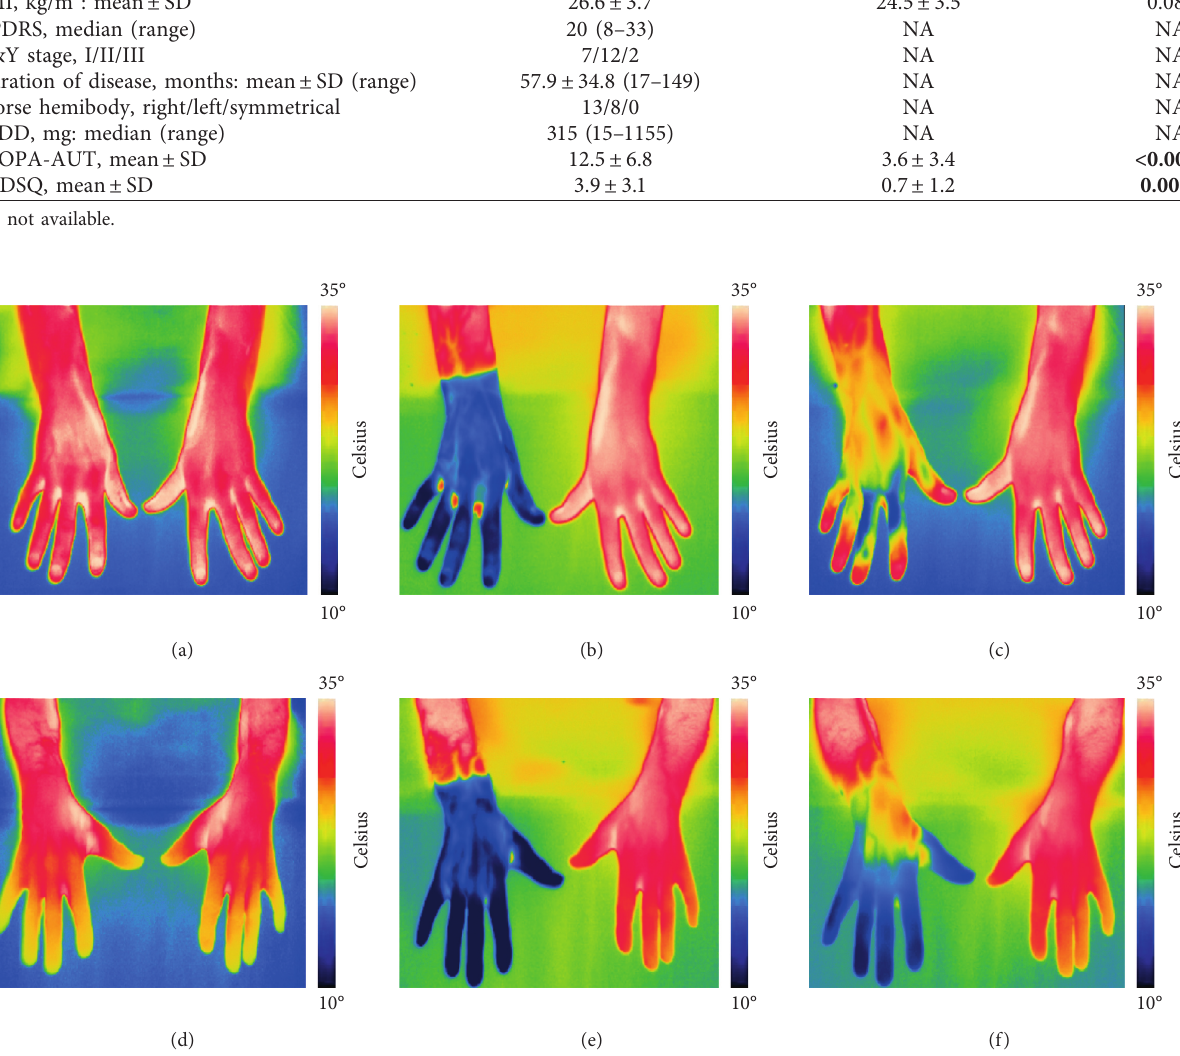
Figure 2: Thermographic images. A series of images from a healthy control ((a)–(c), RR � 75.0%) and a PD patient ((d)–(f), RR � 31.9%). Images at baseline (a, d), T 0 postimmersion (b, e), and T 6 postimmersion (c, f) are shown. All images are scaled 10–35 ° C. Note. The reduced recovery of temperature in the PD patient on the right immersed hand